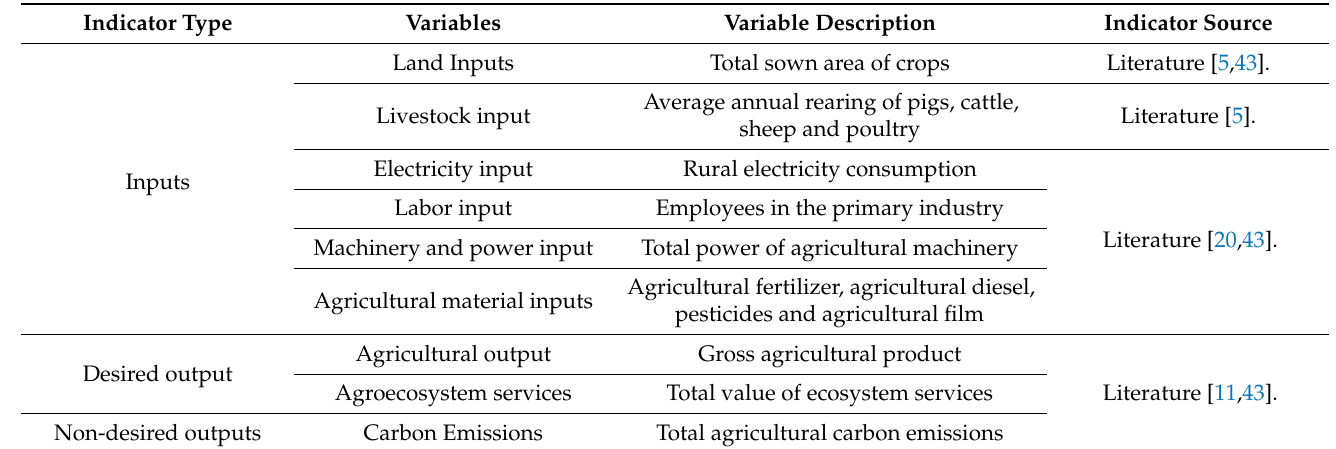
Table 1. AEE index